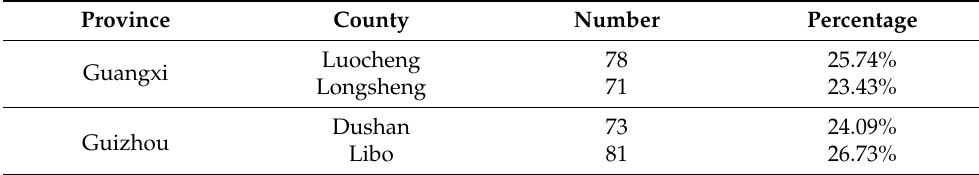
Table 2. Source and distribution of the sample data.